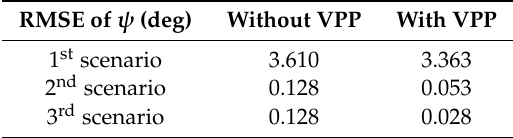
Table 2. Yaw root-mean-square error ( RMSE) of the three simulations. RMSE of ψ (deg) Without VPP With VPP 1 st scenario